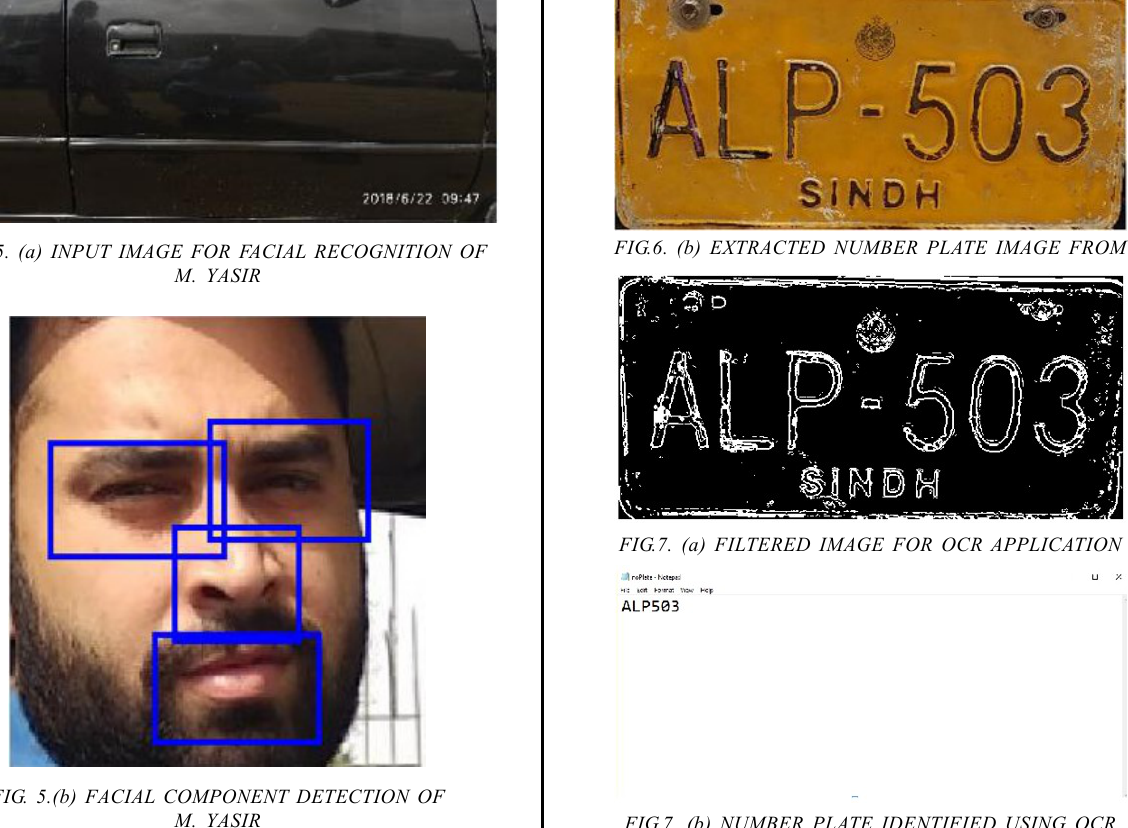
FIG. 5.(b) FACIAL COMPONENT DETECTION OF M. YASIR